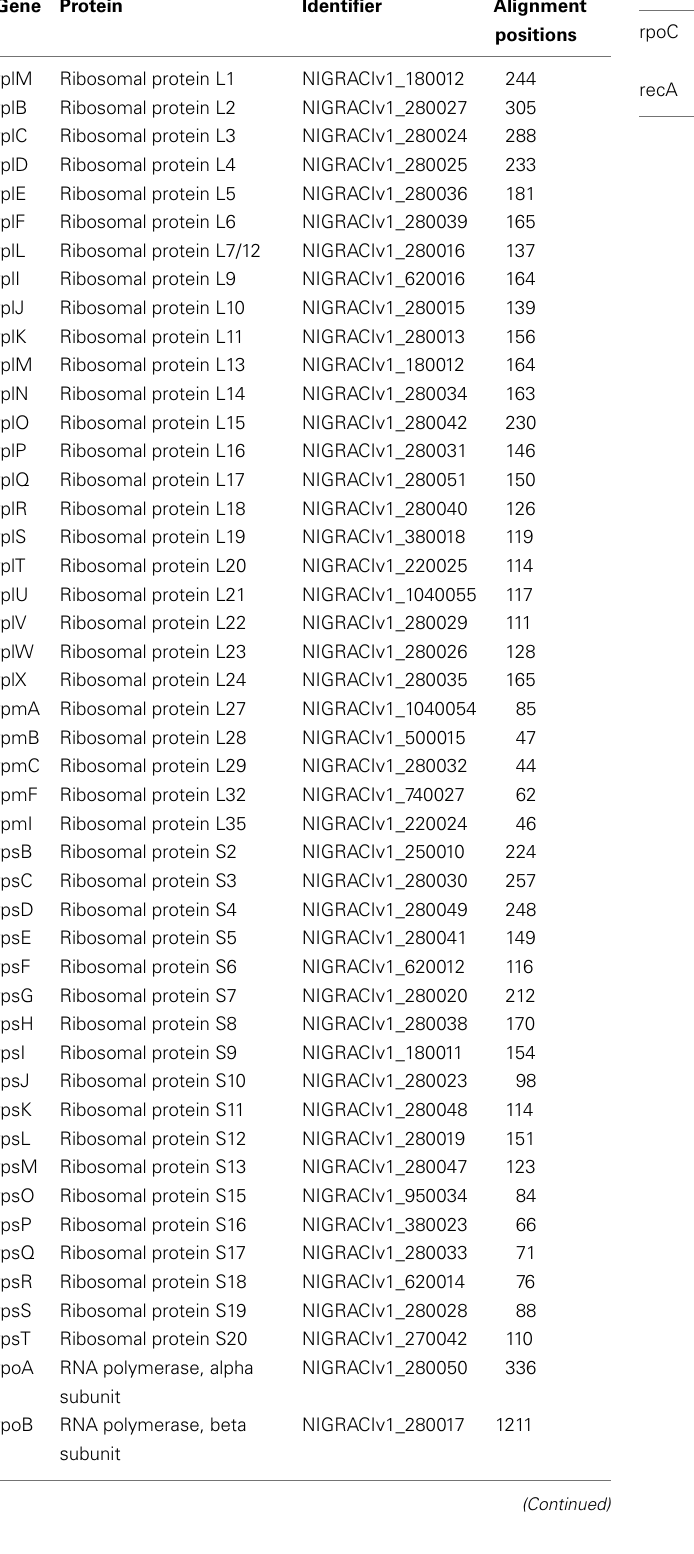
TableA1 | Proteins used for phylogeny.